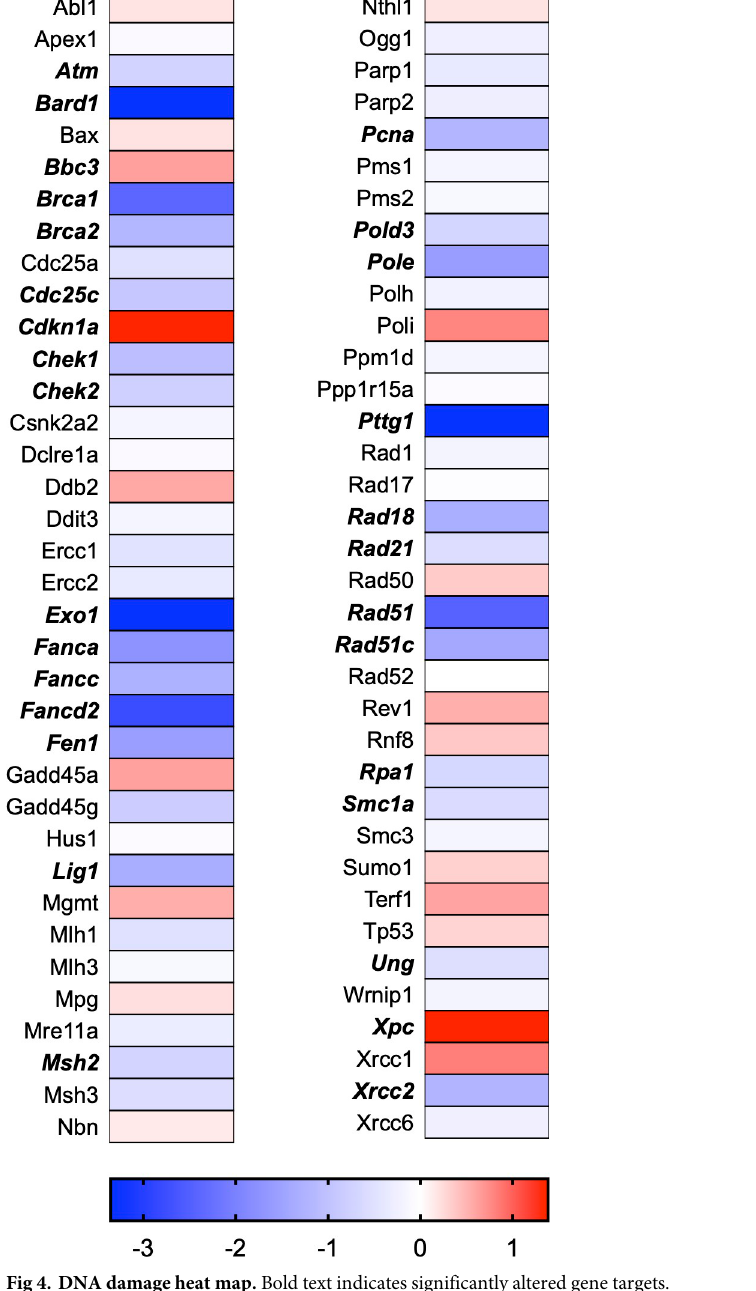
Fig 4. DNA damage heat map. Bold text indicates significantly altered gene